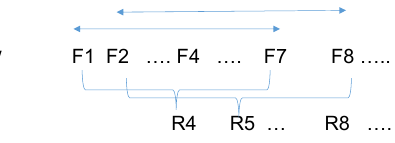
Figure 5. Generation of the Ref sequence. N = 7 in this example.